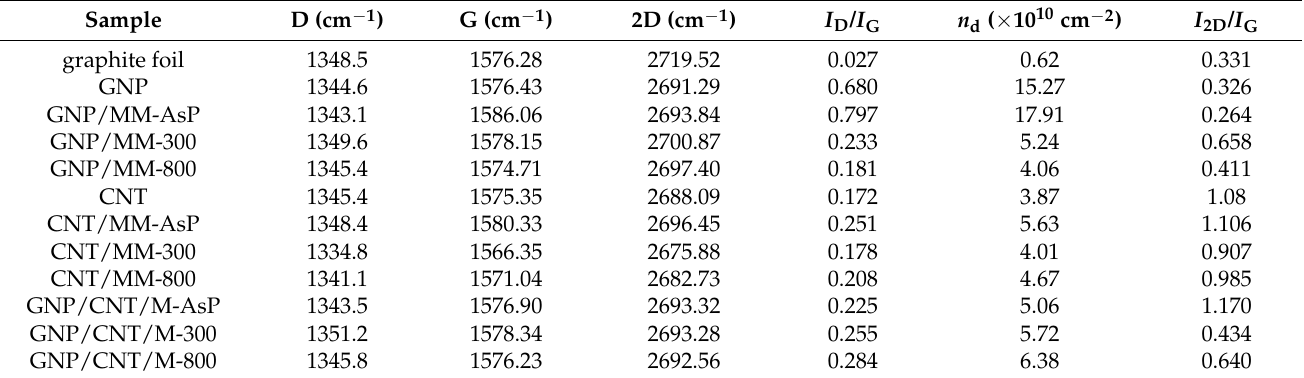
Table 1. Parameters of the Raman scattering